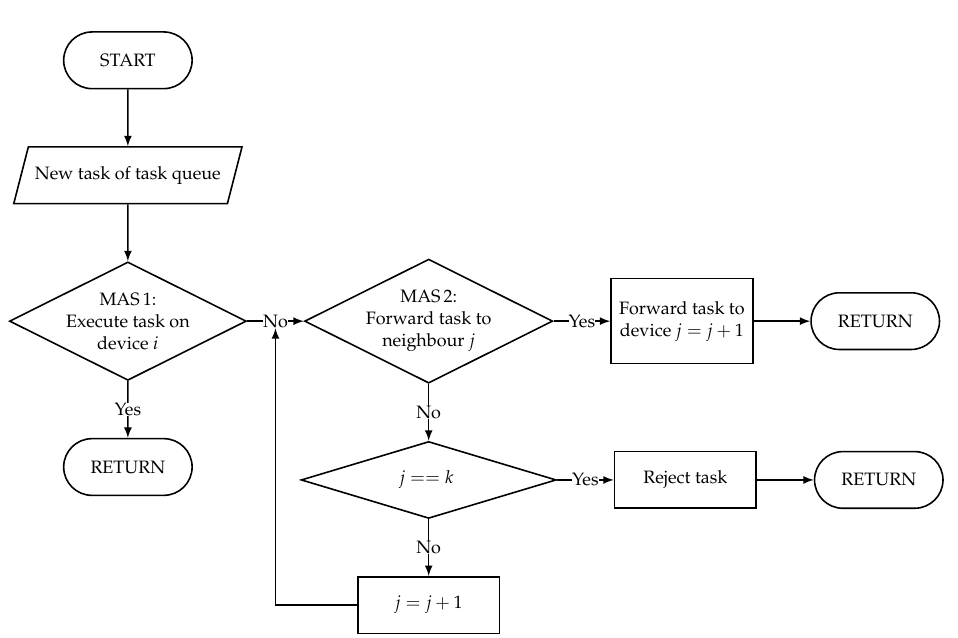
Figure 7. Interaction of MAS1 and MAS2 on one computing unit with k